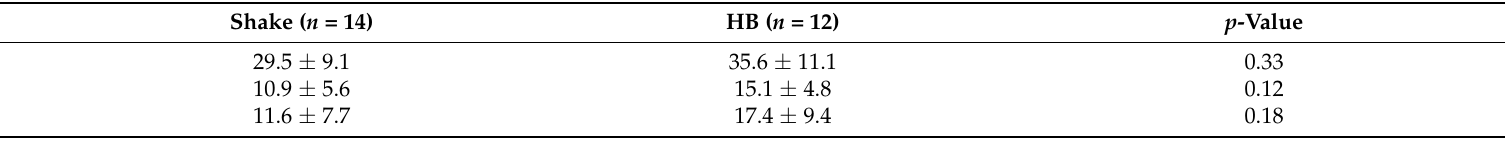
Table 7. Fecal short chain fatty acid concentration for FVC vs. Placebo